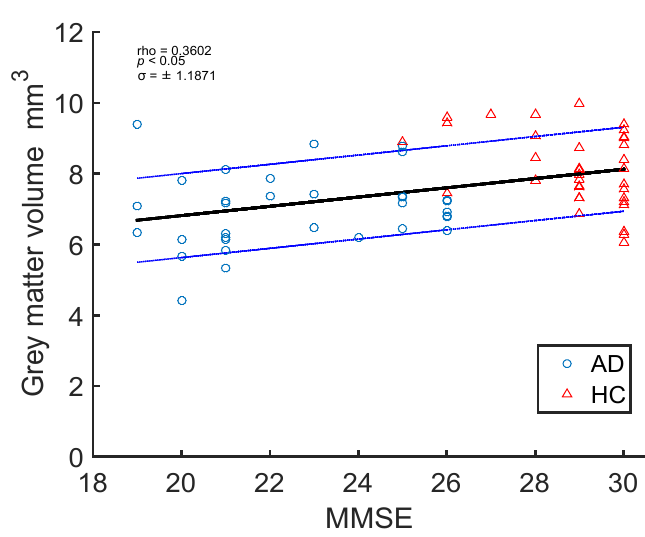
Figure 5. Correlation between GMV and MMSE within groups in the left superior temporal